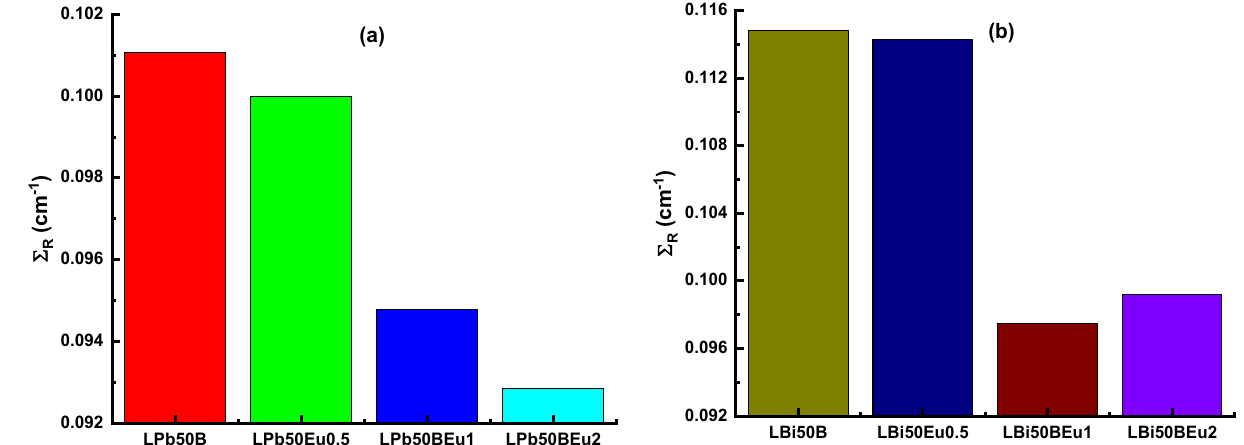
Figure 8. Variation of energy absorption build-up factor (EABF) against photon energy for ( a ) LPb50BEu and ( b ) LBi50BEu glasses.